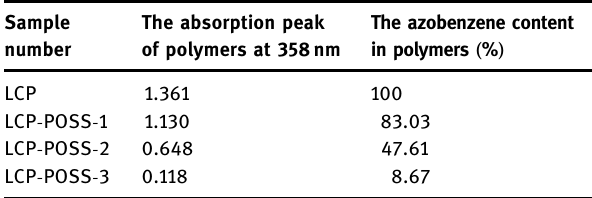
Table 4: Percentage compositions of the actual polymerized liquid